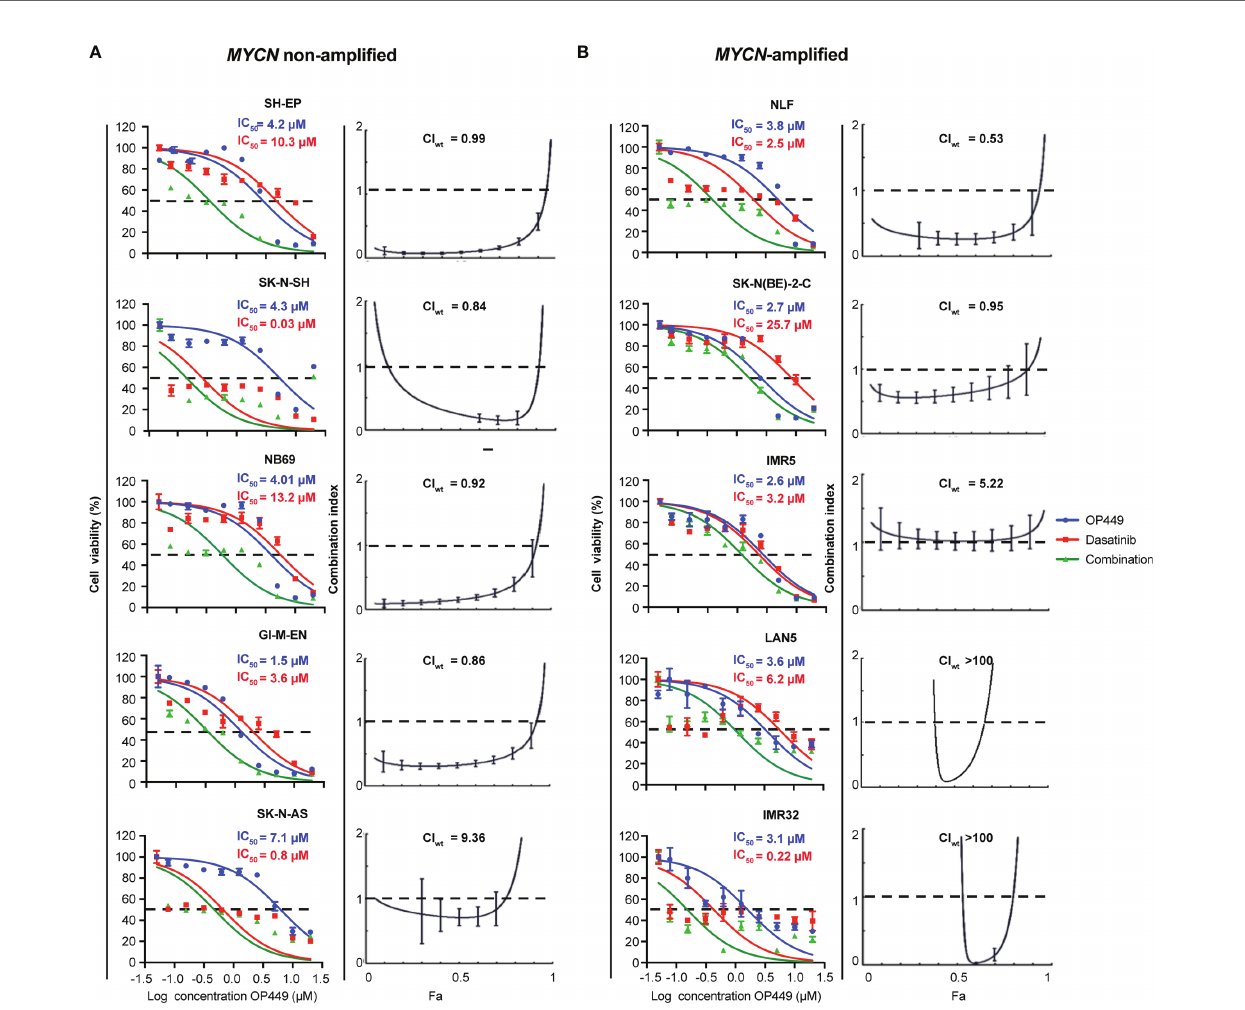
FIGURE 7 | Synergistic effect of OP449 and dasatinib in a panel of MYCN -ampli fi ed and non-ampli fi ed neuroblastoma (NB) cell lines. Cells were treated for 72 h with OP449, dasatinib, or a combination of both. Cell viability determined by MTT is depicted as percentage of untreated cells, and IC 50 is shown. CI and weighted CI (CI wt ) were determined. A CI or weighted CI of less than 1 indicates synergy, 1 an additive effect, and greater than 1 an antagonist effect. (A) OP449 and dasatinib synergistically inhibit SH-EP, SK-N-SH, NB69, and GI-M-EN but not SK-N-AS MYCN non-ampli fi ed cells. The left panels show dose-response curves plotted as log of OP449 concentrations ranging from 0 to 20 µM at a molar ratio of 1 (OP449) to 1.25 (dasatinib) for SH-EP cells and 1 to 2.5 for the other cell lines. The right panels show Fa-CI plots. CI wt is stated for each Fa-CI plot. (B) OP449 and dasatinib synergistically inhibit NLF and SK-N-BE(2)-C but not IMR5, LAN5, and IMR32 NB MYCN- ampli fi ed cells. The left panels show dose-response curves plotted as log of OP449 concentrations ranging from 0 to 20 µM at a molar ratio of 1 (OP449) to 2.5 (dasatinib). The right panels show Fa-CI plots. CI wt is stated for each Fa-CI plot. The vertical bars on Fa-CI plots represent 95% con fi dence intervals. All experiments were repeated three